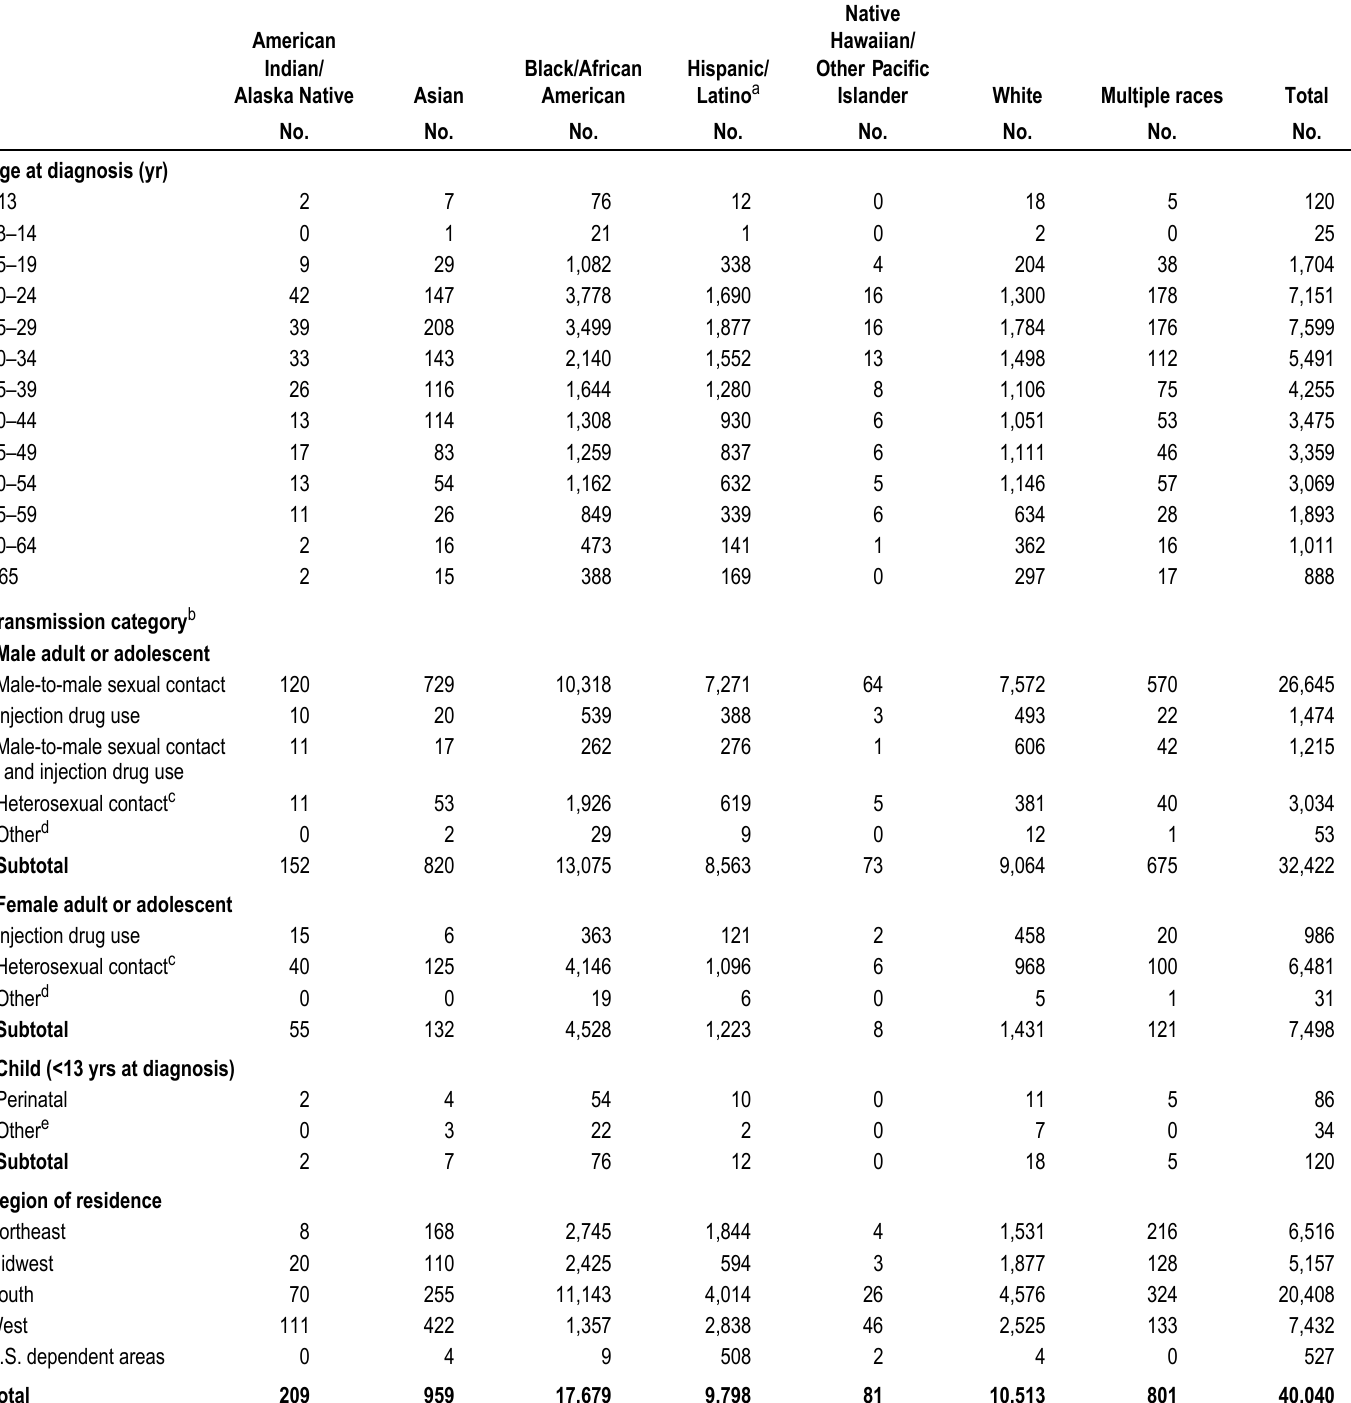
Table 3b. Diagnoses of HIV infection, by race/ethnicity and selected characteristics, 2015—United States and 6 dependent